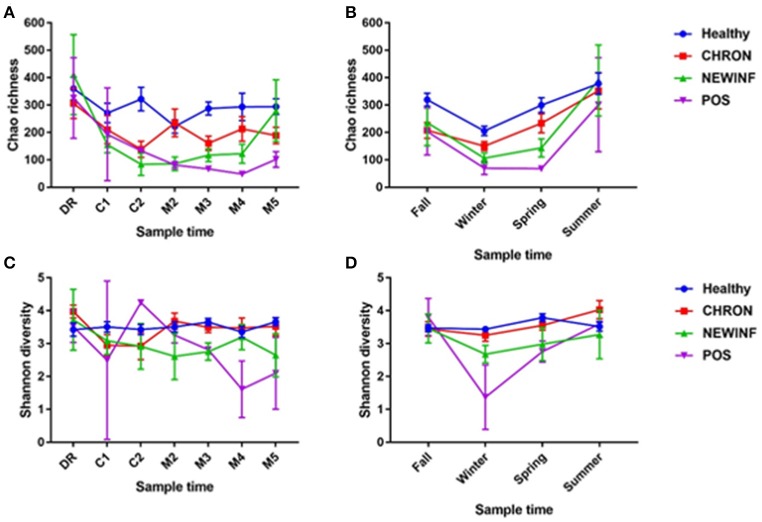
Richness across lactation (A) and by season (B) and diversity across lactation (C) and by season (D) for each cohort. Healthy, Quarters that had culture-negative milk with SCC < 100,000 cells/mL at DR, C1, and C2. CHRON, Chronically inflamed quarters that had culture-negative milk samples with SCC ≥ 150,000 cells/mL at DR and C1. NEWINF, Quarters that had new culture-negative inflammation with variable DR milk sample results and culture-negative milk samples with SCC ≥ 150,000 cells/mL at C1 and C2. POS, Quarters that had bacterial growth in culture and SCC ≥ 150,000 cells/mL at DR, C1, and C2. DR, dryoff; C1, first week of lactation; C2, second week of lactation; M2, second month of lactation; M3, third month of lactation; M4, fourth month of lactation; M5, fifth month of lactation.